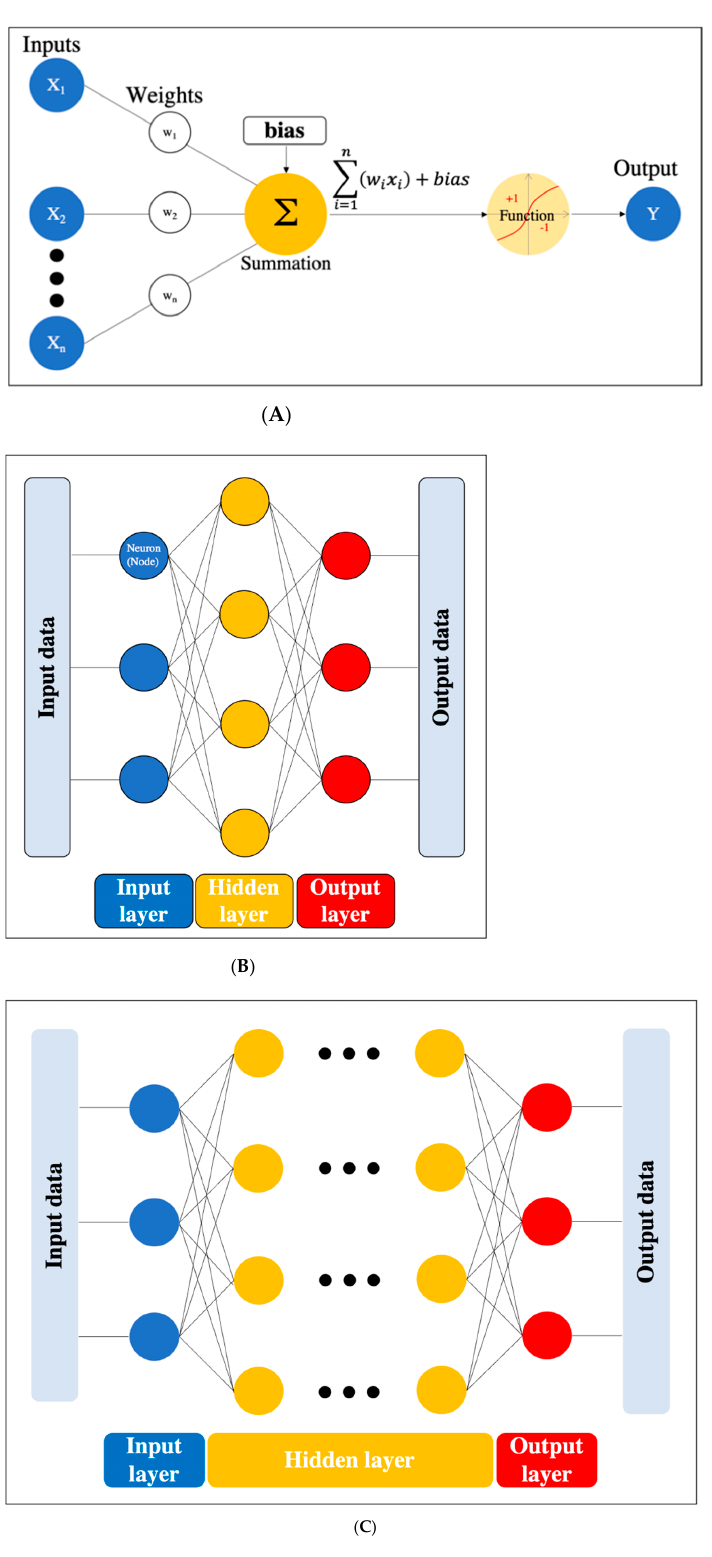
Figure 2. Artificial neural network. ( A ) Simple perceptron. ( B ) Neural network. ( C ) Deep neural network (DNN). Black dots: multiple hidden layers.